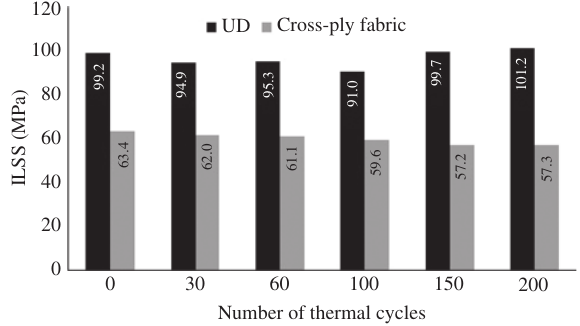
Figure 4: ILSS of the UD and cross-ply fabric composites subjected to different thermal cycles.